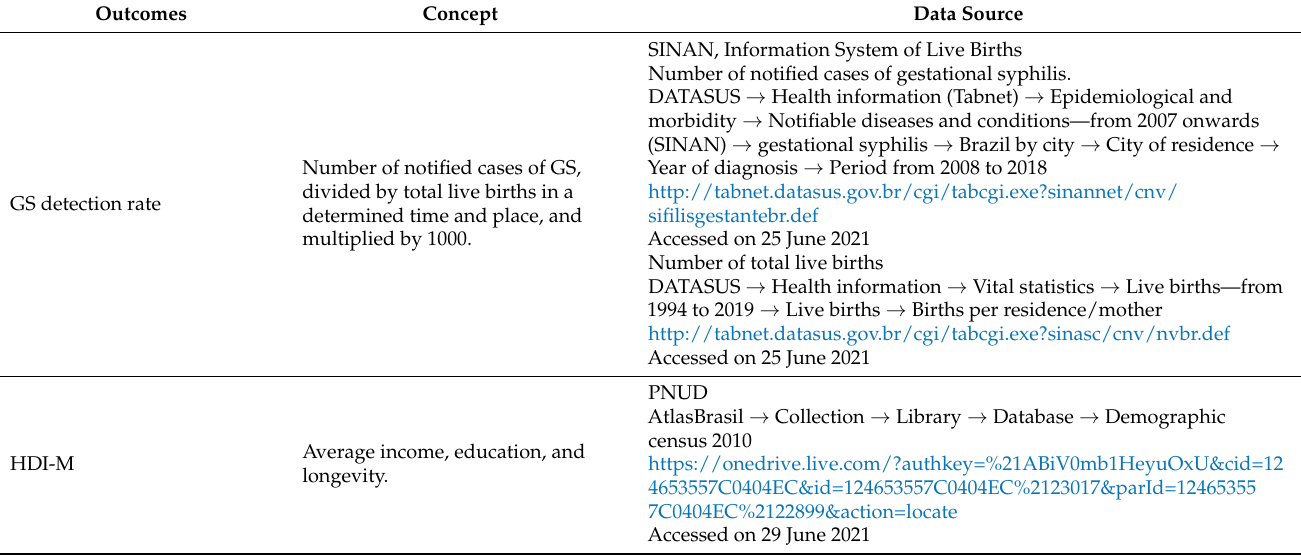
Table 1. Indicators of gestational syphilis detection rate, health care, and socioeconomic and health conditions. Brazilian cities, 2008 to